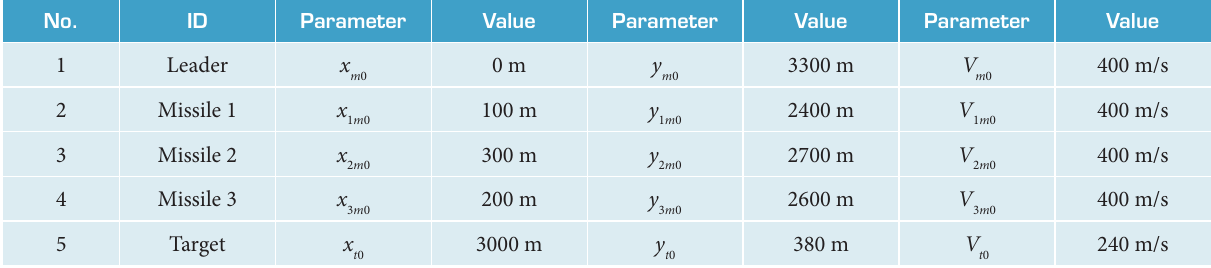
Figure 2. Communication topology of the leader and followers. Table 1. Initial conditions of the leading interceptor, following interceptors, and